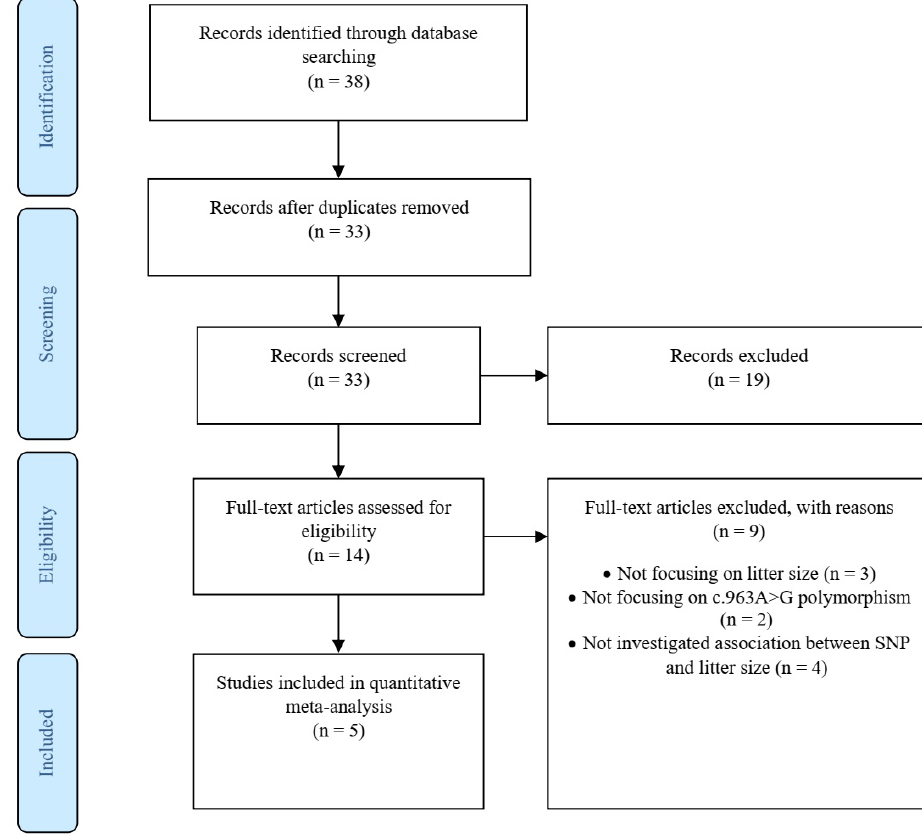
Figure 1. The PRISMA flowchart showing inclusion and exclusion